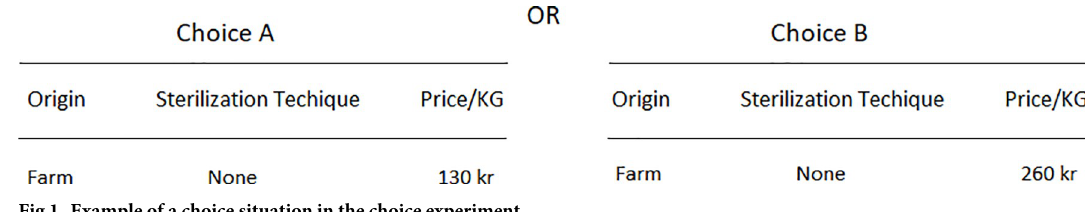
Fig 1. Example of a choice situation in the choice